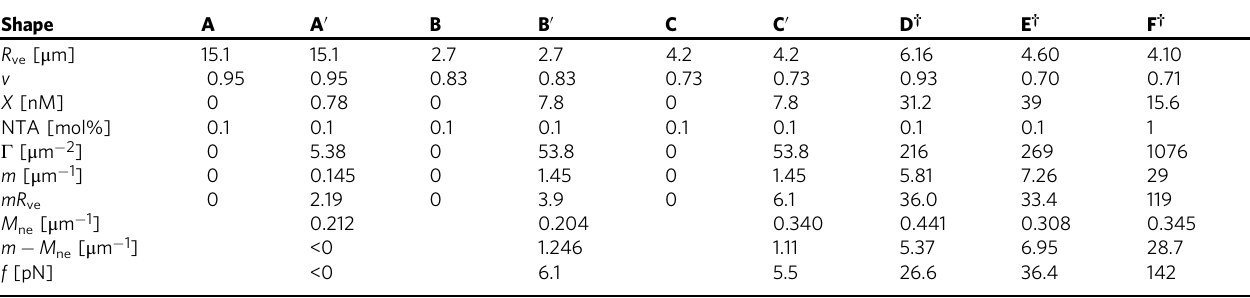
Table 1 Vesicle size R ve , volume-to-area ratio v , molar GFP concentration X , mol% DGS-NTA anchor-lipids, GFP coverage Γ , spontaneous curvature m , and rescaled spontaneous curvature mR ve for the six vesicle shapes A, A 0 , B, B 0 , C, and C 0 depicted in Fig. 2c,